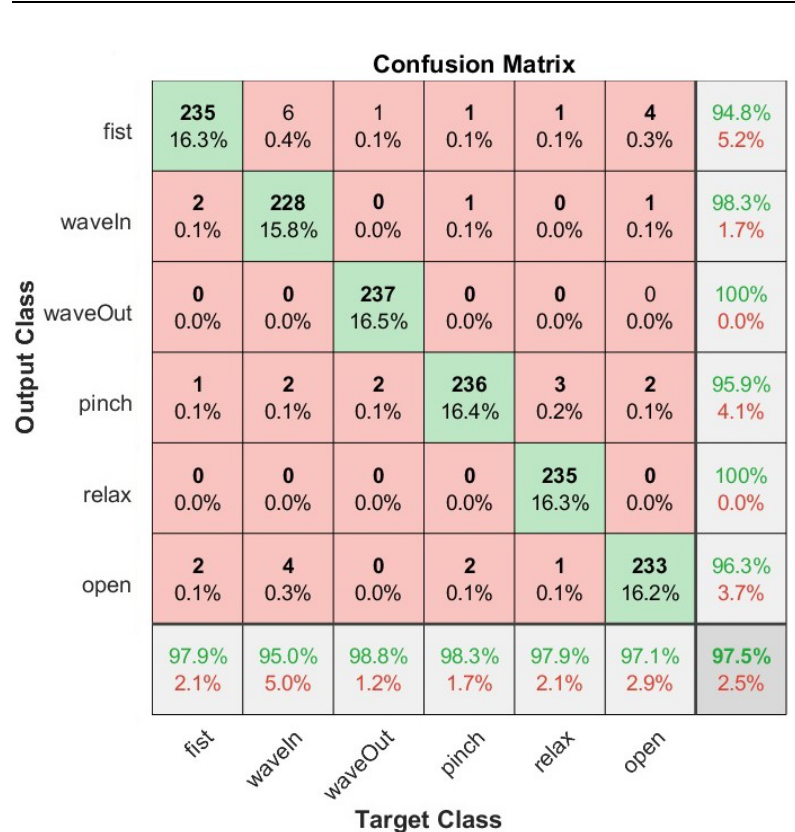
Figure 6. User-specific HGR model confusion matrix for 16 users from the test set with the best hyperparameter configuration for the Myo armband sensor for static